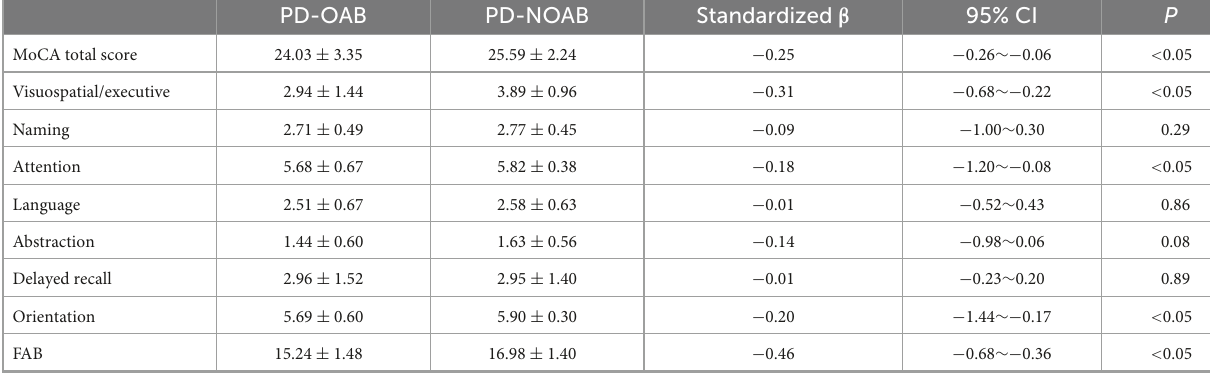
TABLE 2 Linear regression analysis of cognitive performance with